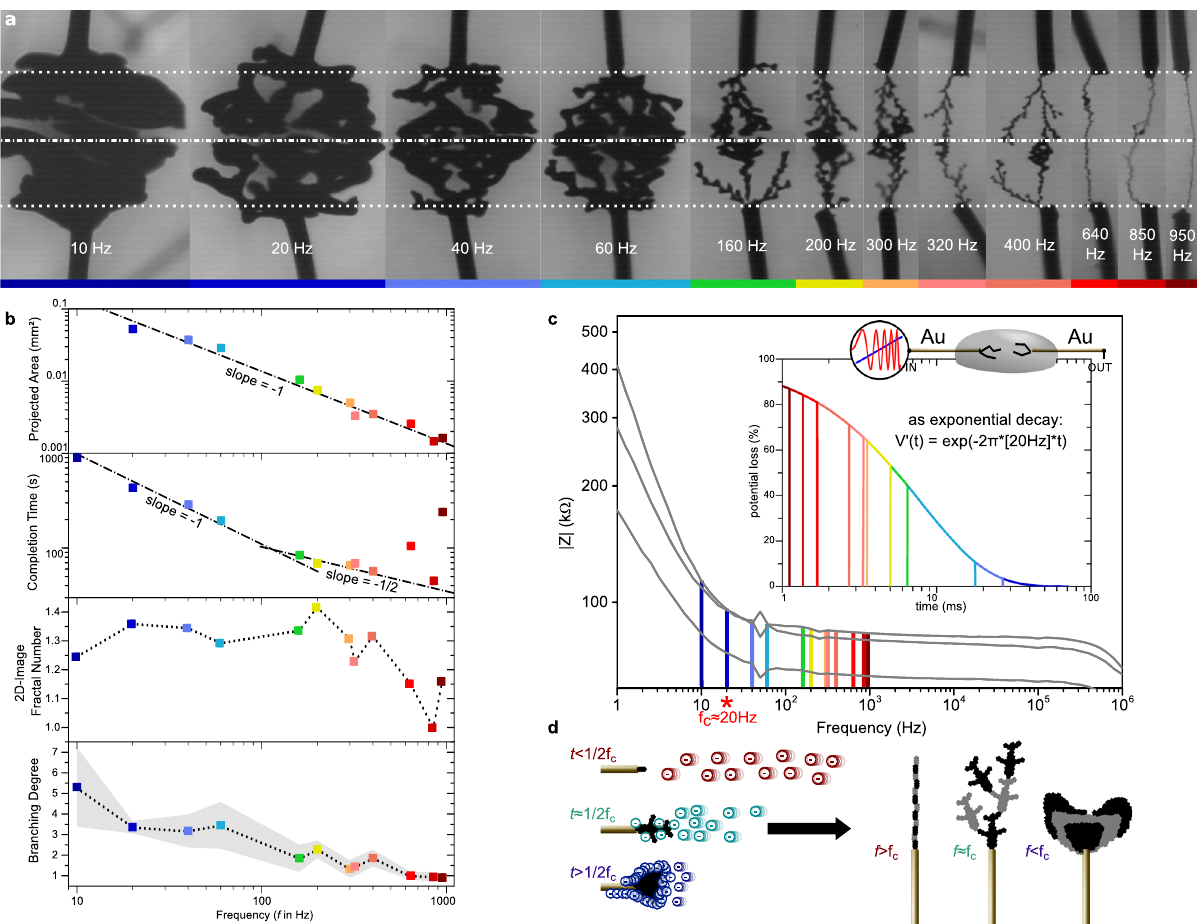
Fig. 4 Fractal control by the frequency ( f ). a Microscope pictures of ePEDOT dendritic formations (signal wire: top, ground wire: bottom) at their completion time grown under various frequencies from 10 to 950 Hz ( V p = 5 V, V off = 0 V, dc = 50%). b Projected area, completion time, fractal number of their image, and branching degree over f for dendrites grown up until contact. The gray-colored error interval on the branching degree is set to the mean value ± SD (six values along L for each f ). c Impedance spectroscopy of the two-wire setup after three different dendritic formations (see details on the three evaluated dendrites as Supplementary Information), performed in 1 mM NaPSS (aq) (without EDOT (aq) nor BQ (aq) ), that displays in the three cases a change in the frequency-dependent regime of the modulus at f c around 20 Hz. Inset: Decay over time of the potential across the wire assuming an ideal resistor-capacitor discharge, and an exponential decay rate τ = 1/[2 π *20 Hz]. d Schematics for the growth of three different dendrites with morphological dependencies associated to anionic screening during polarization responsible for the potential drop at the anode, for which the hindrance time dependency is associated to the frequency and the f c of the electrochemical system. Scatters ’ color encodings with frequency in a , b , and c are